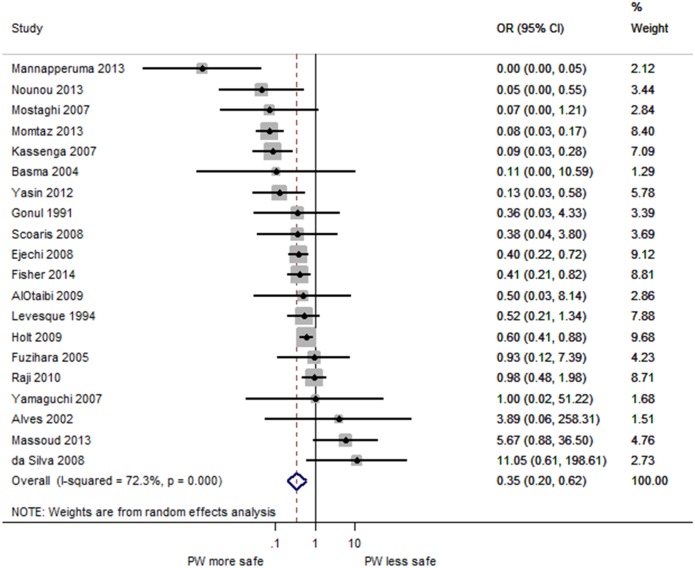
Forest plot of PW and all other drinking water sources.Forest plot of the odds ratio of fecal contamination comparing PW and all other drinking water sources.